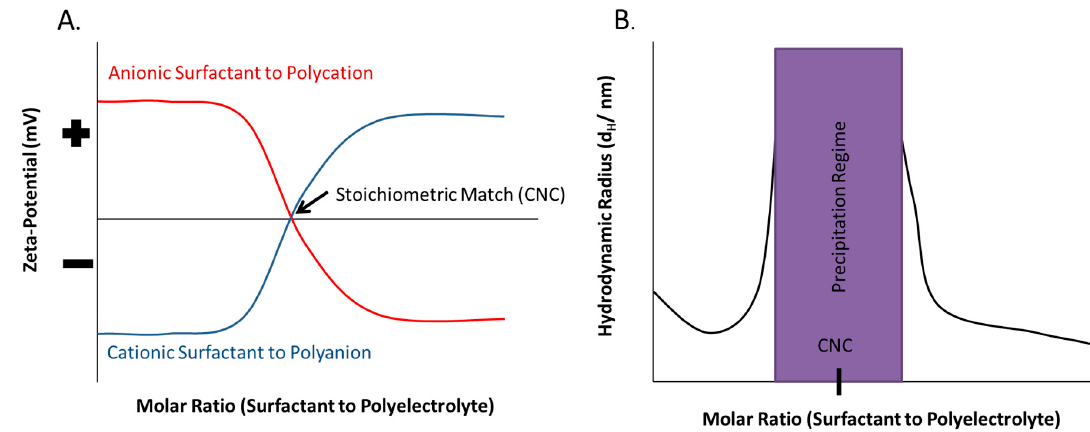
Figure 8. ( A ) Zeta-potential versus molar ratio of surfactant to polyelectrolyte. ( B ) Hydrodynamic radius versus molar ratio of surfactant to polyelectrolyte. Adapted from [107,108,115,116] .